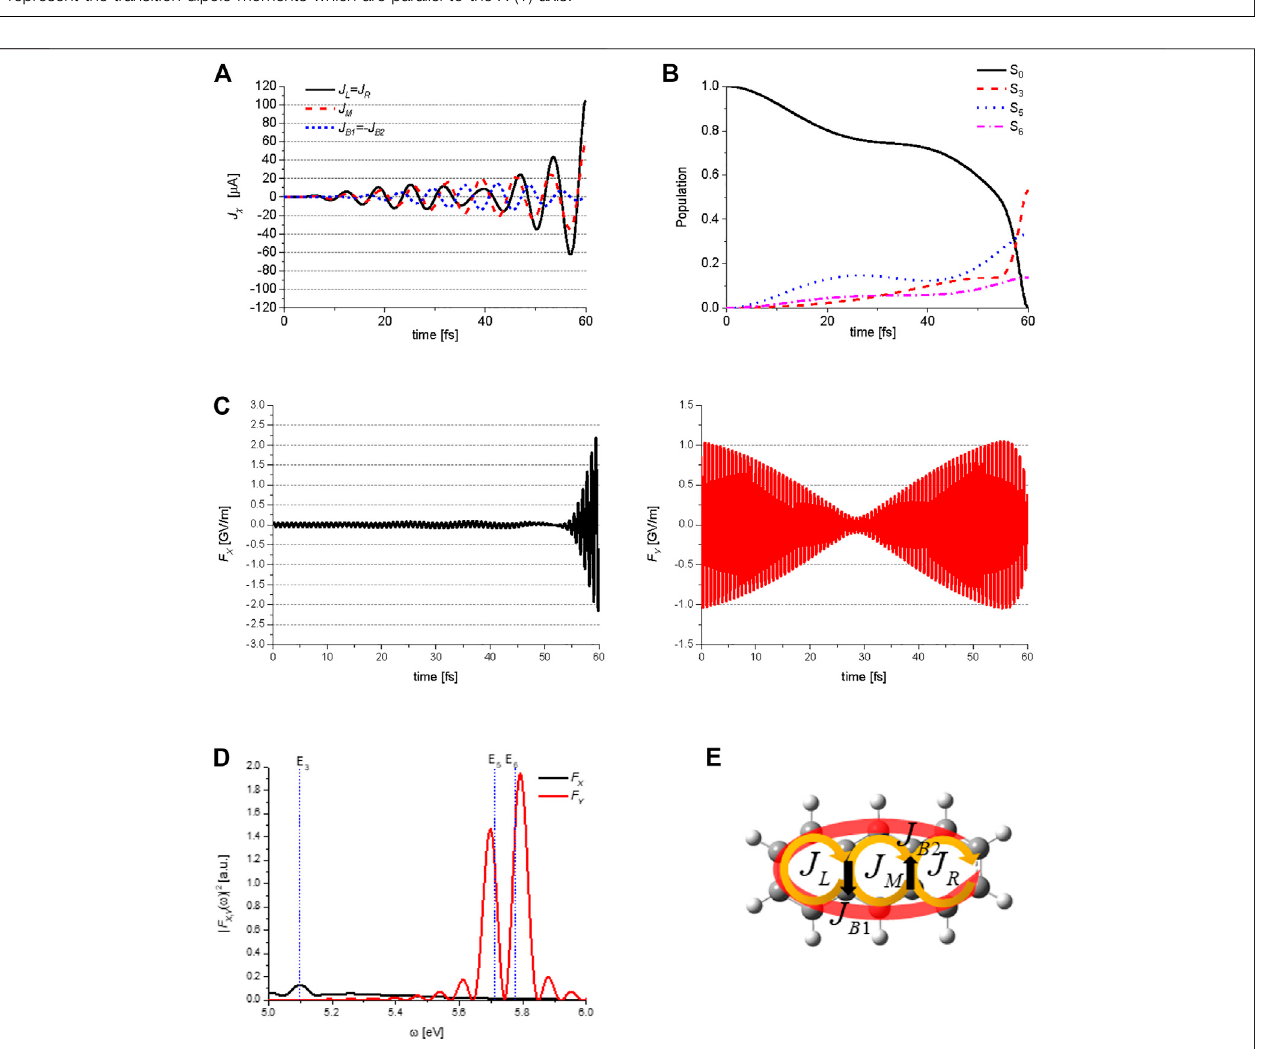
FIGURE 8 | Quantum optimal control simulations for generation of the perimeter ring current in anthracene: (A) temporal behavior of the three ring currents J L ( t ) (cid:2) J R ( t ) (solid line), J M ( t ) (broken line), and those of the two bridge bond currents J B 1 ( t ) (cid:2) − J B 2 ( t ) (dotted line); (B) temporal behavior of the population in S 0 , and those in the three excited states: S 3 (B 2u ), S 5 (B 2u ), and S 6 (B 2u ); (C) optimized X -polarized laser pulse fi eld F X ( t ) (left-hand side) and Y -polarized F Y ( t ) (right-hand side) ; (D) Fourier transformed spectra of the two laser fi elds F X ( ω ) and F Y ( ω ); (E) fi ve components of the perimeter ring current at an arbitrary time. Reprinted with permission from Ref. [40] Copyright (2012) American Chemical Society.